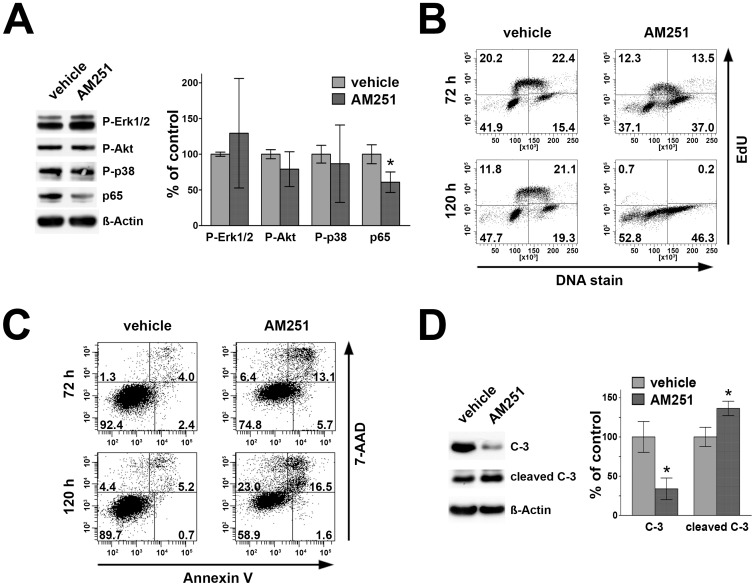
Effects of CB1 inhibition on signal transduction, p65-level, cell cycle profile and apoptotic populations in L428 cells.L428 cells were treated with 10 µM AM251. A) Western blot analysis of crude cell extracts showing a reduction of p65 whereas P-Erk1/2, P-Akt and P-p38 MAPK were not significantly altered compared to vehicle. B) Cell cycle analysis using EdU/DNA-stain and flow cytometric analysis showed strong decline of cells in S-phase and relative increase of cells in G2M phase. C) AnnexinV/7-AAD staining and subsequent flow-cytometric analysis revealed that after 72 h and 120 h of AM251-treatment, the number of vital cells decreased and apoptotic, necrotic and dead fractions were elevated. D) Processing of caspase-3 in a representative Western blot and its statistical analyses of L428 cells treated with AM251 for 96 h. AM251-treatment resulted in higher amounts of cleaved of caspase-3 (cleaved C-3) accompanied by a decrease of full length caspase-3 (C-3). Values represent means ± SD of 3 independent experiments.